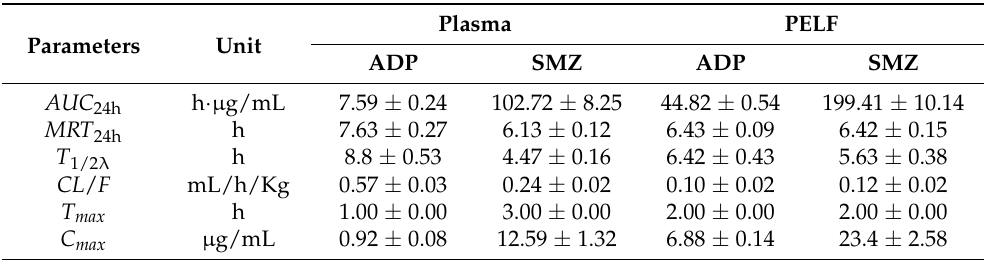
Table 6. The PK parameters of ADP and SMZ in plasma and PELF after intramuscular injection of